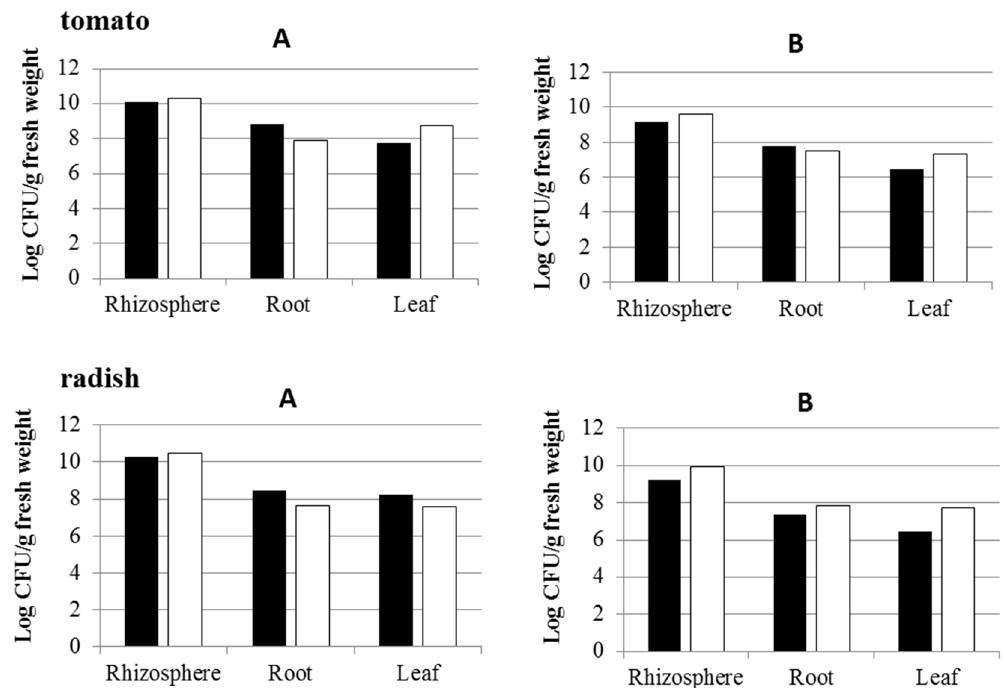
Figure 5. Colonization in plant parts by Klebsiella sp. Sal 1 (closed box) and by Herbaspirillum sp. Sal 6 (open box) individually ( A ) and co-inoculated ( B ) to tomato and radish seeds (n = 1).